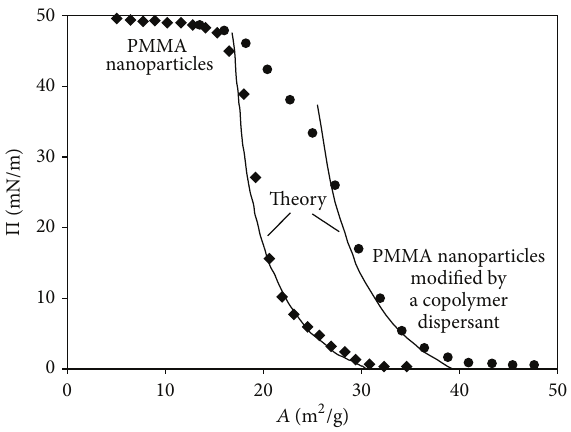
Figure 2: Comparison of experimental and theoretical isotherms for bare polymethylmethacrylate (PMMA) particles and PMMA particles with the surface modified with a copolymer. See the qualitative agreement between the experimental results and the theoretical model described by (4). The size of the particles was 113nm. Reprinted with permission from [48]. Copyright 2006, American Chemical Society.